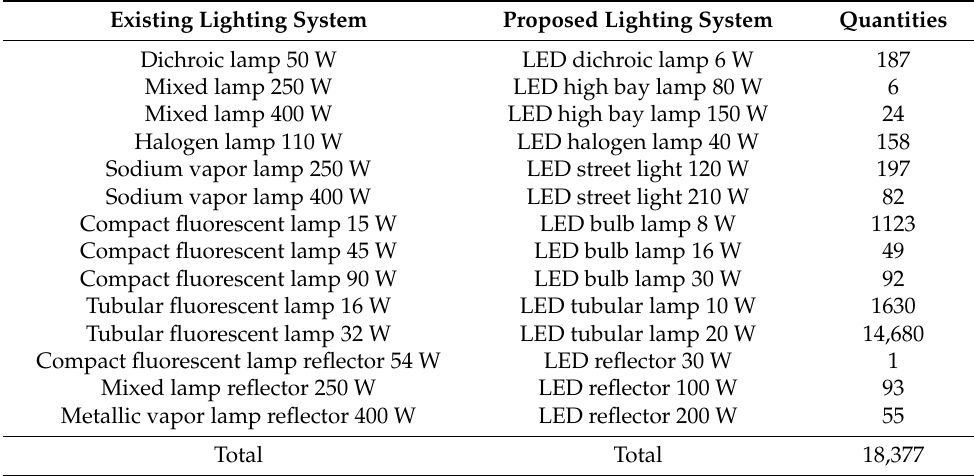
Table 6. Equivalence of the Lighting Systems.